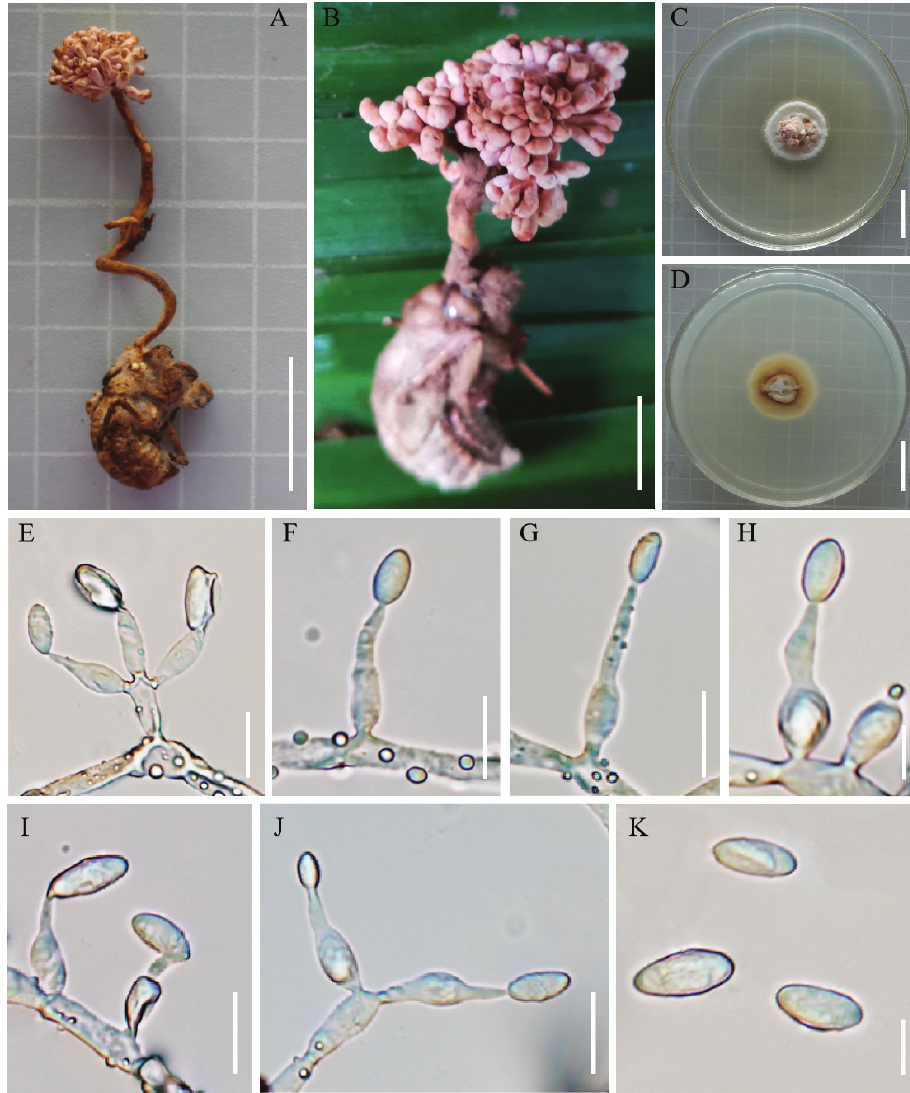
Figure 2. Ophiocordyceps hydrangea A, B fungus on a cicada nymph C, D colony on PDA medium E conidiophores, conidiogenous cells and conidia F–J conidiogenous cells and conidia K conidia. Scale bars: 1 cm ( A, B ); 2 cm ( C, D ); 10 µm ( E, F, G, I, J ); 5 µm ( H, K